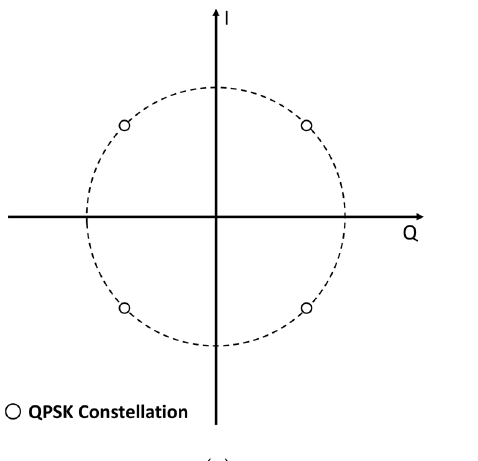
Figure 1. Ring-shaped signaling system block diagram.